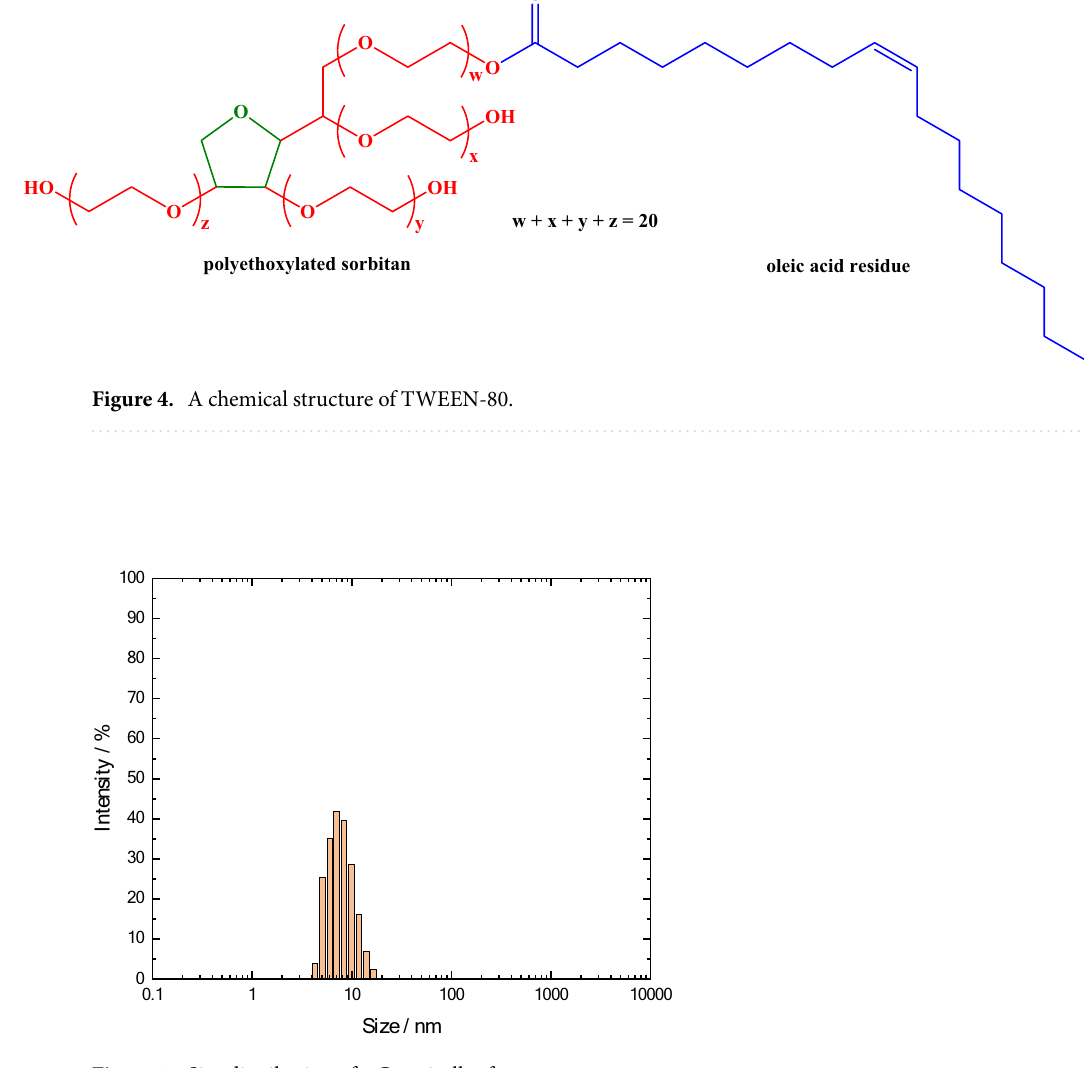
Figure 5. Size distribution of a C 60 micellar